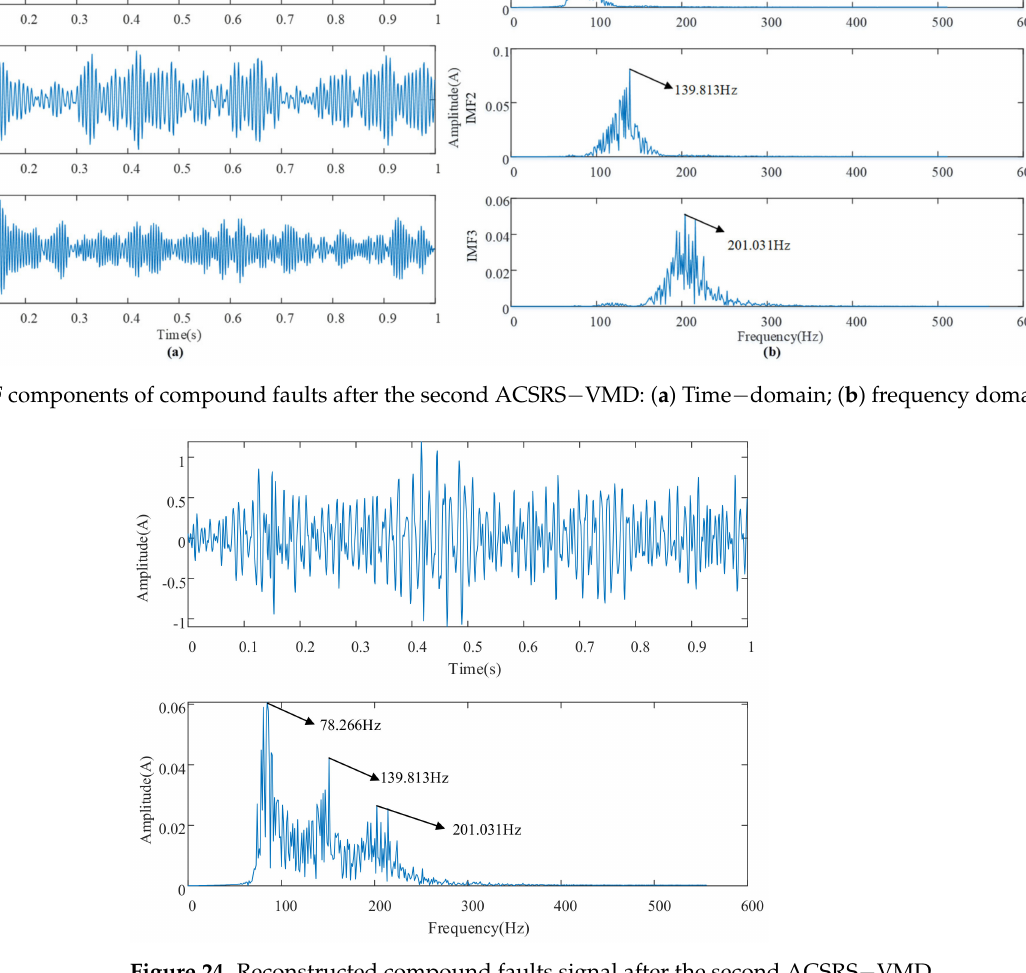
Figure 24. Reconstructed compound faults signal after the second ACSRS −